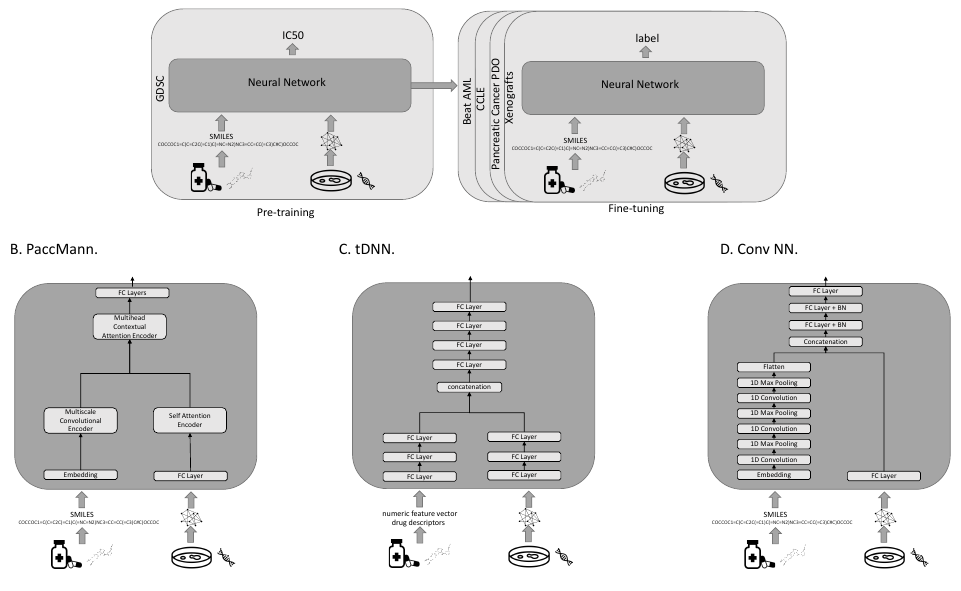
Figure 1. Overall model architecture ( A ) and models. Model architectures for the PaccMann model ( B ), the tDNN model ( C ), and the Conv NN ( D